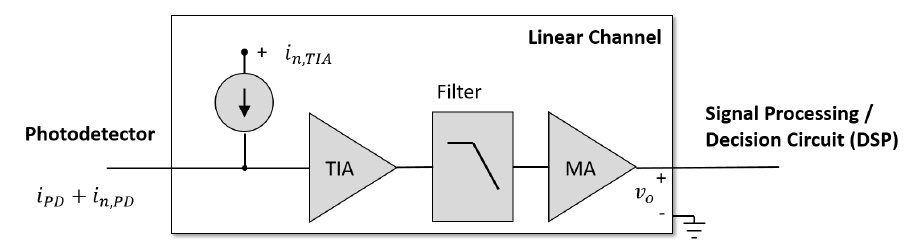
Figure 1. The context and the structure of the linear channel for a typical